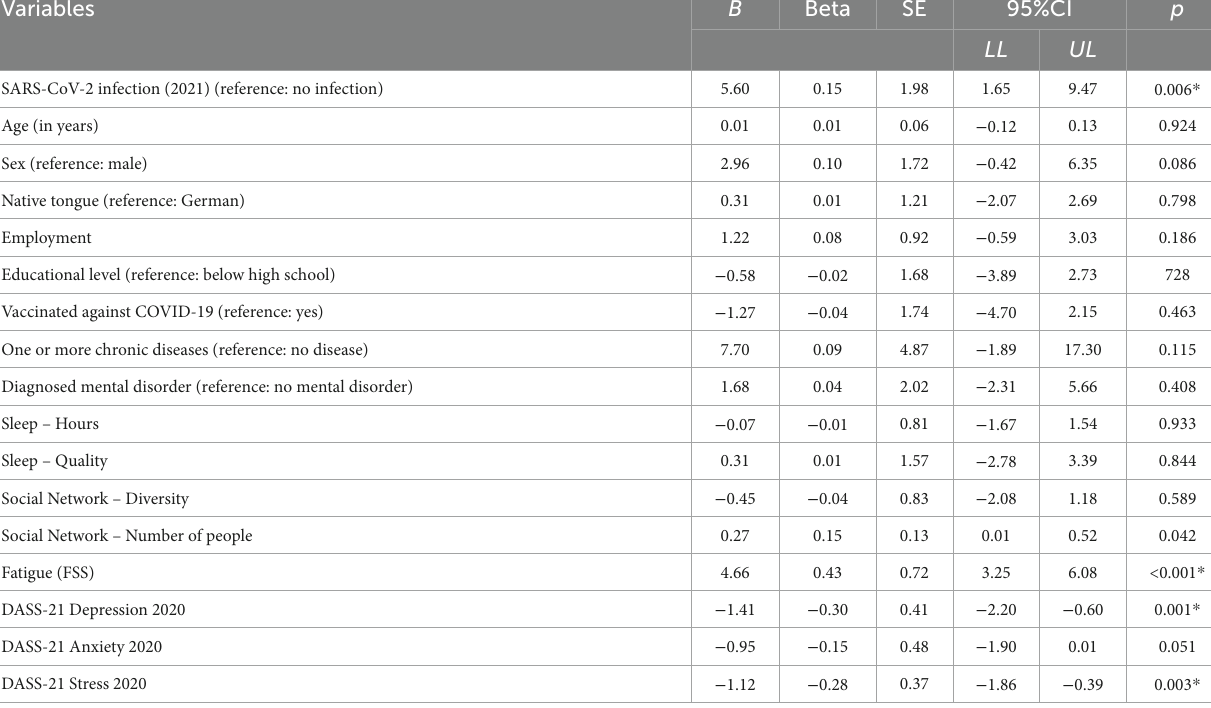
TABLE 7 Multiple linear regression analyses showing the association between confirmed SARS-CoV-2-infection and changes in depression, anxiety and stress levels (DASS-21 total score) between 2020 and 2021 ( n = 305). Variables B Beta